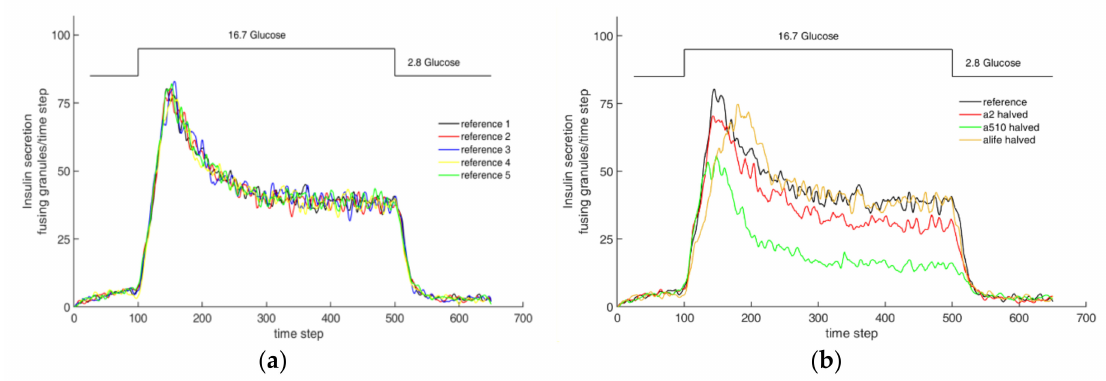
Figure17. Parameterstudiesonthebiphasicbehaviourwithnetwork#1, ( a )influenceoftherandomness: 5 simulations with identical parameters, ( b ) influence of some selected